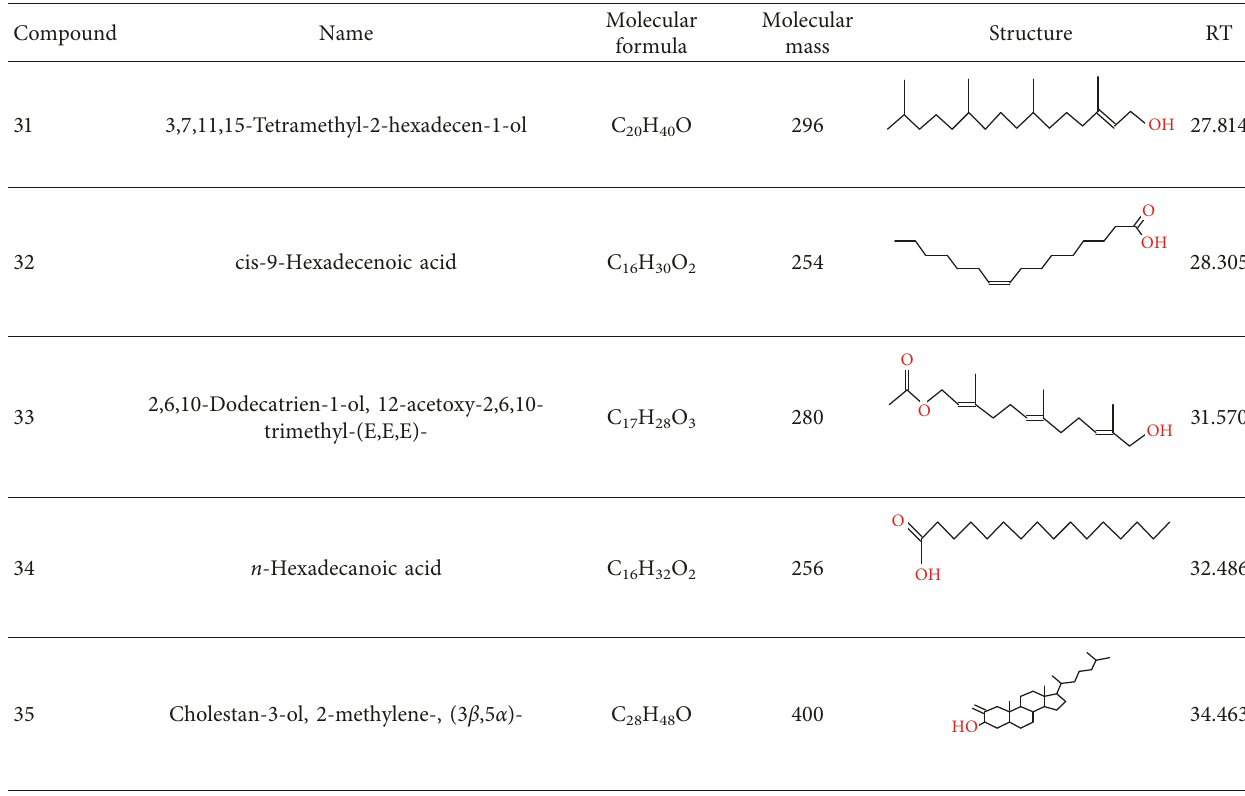
Table 8: Molecular formula, molecular mass, structure, and RTof compounds 31–35 of whole plant n -hexane fraction of Achillea wilhelmsii (WHFAW).